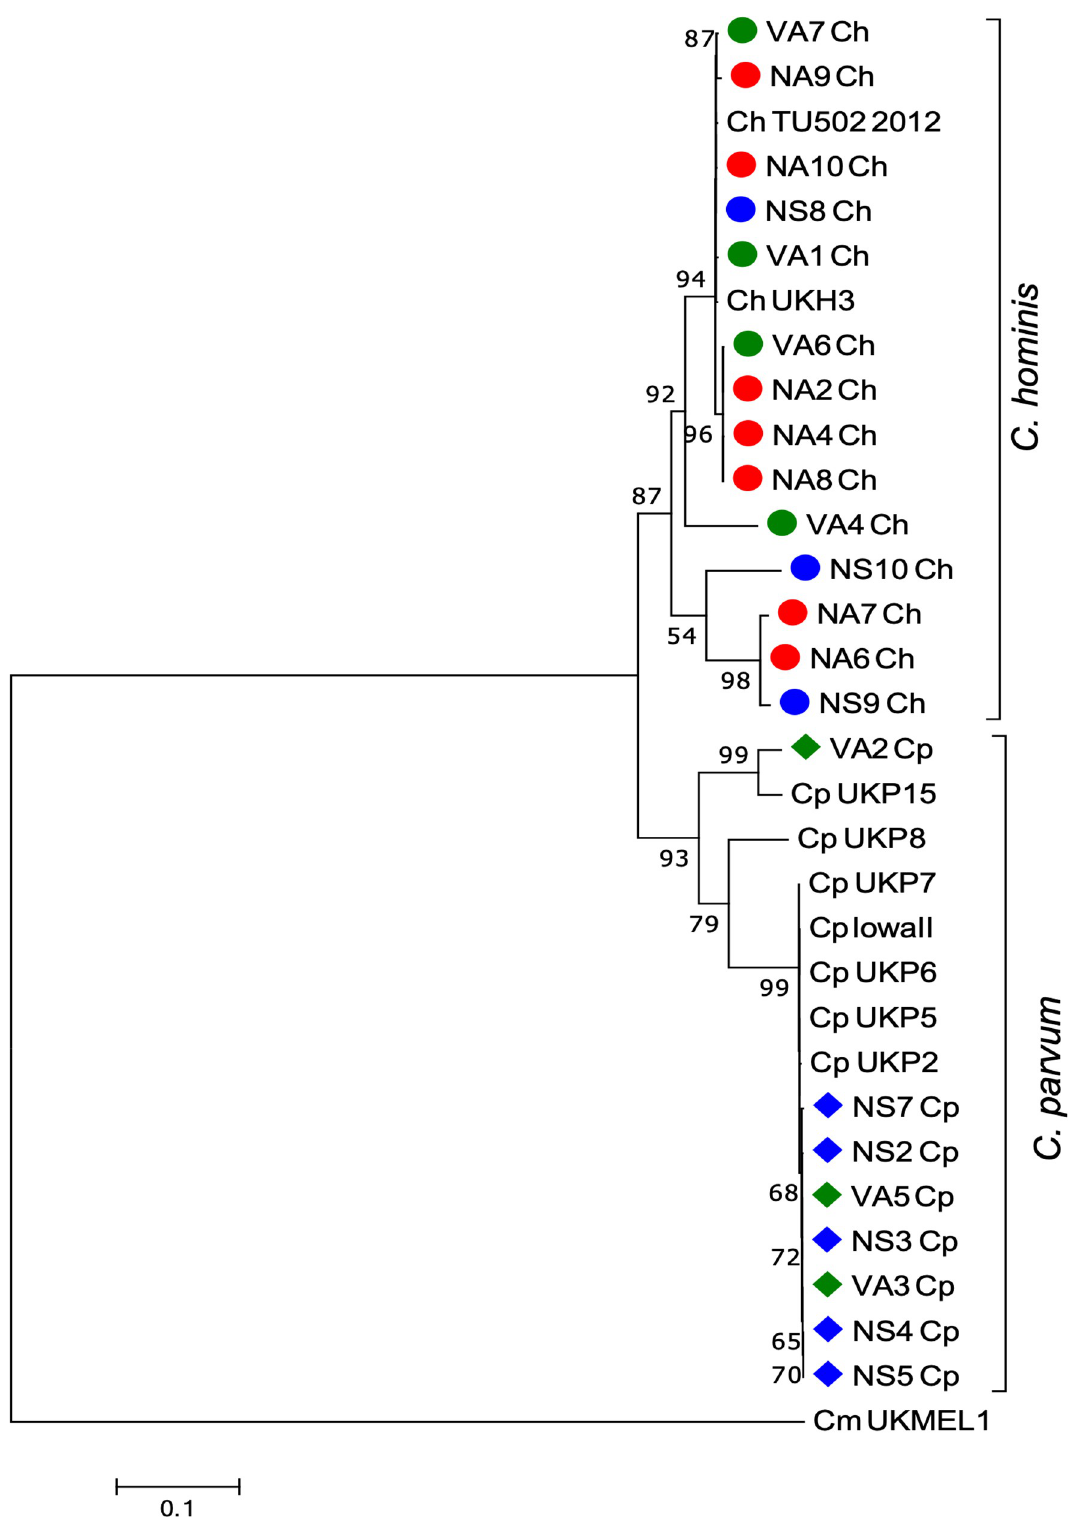
Fig 6. Phylogenetic analysis with the CS of the six markers for the 22 samples from Colombian patients identified as C . hominis and C . parvum .